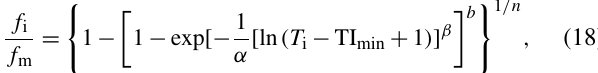
basin, α is the scale parameter of the grid, and β is the shape parameter of the